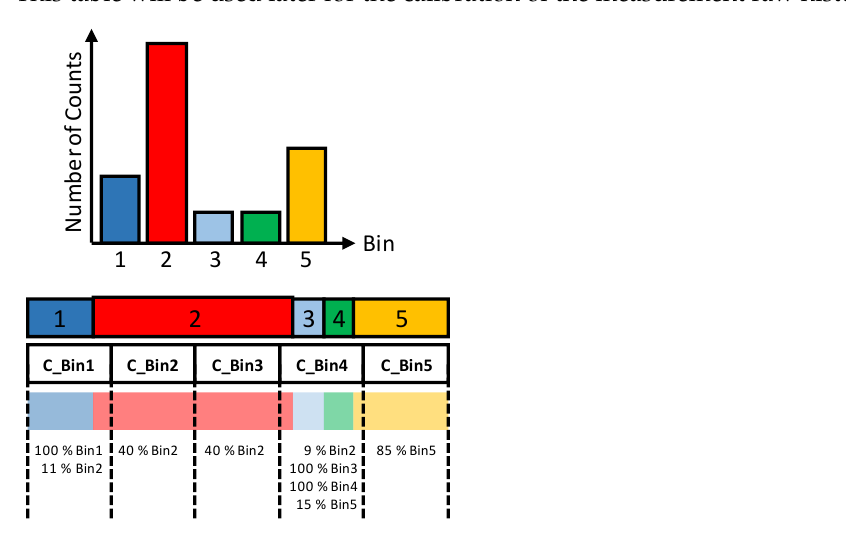
Figure 4. Average-bin-width calibration, redistribution of the total counts on identical calibrated bins and creating the calibration table that defines the percentage share of raw bins in each calibrated